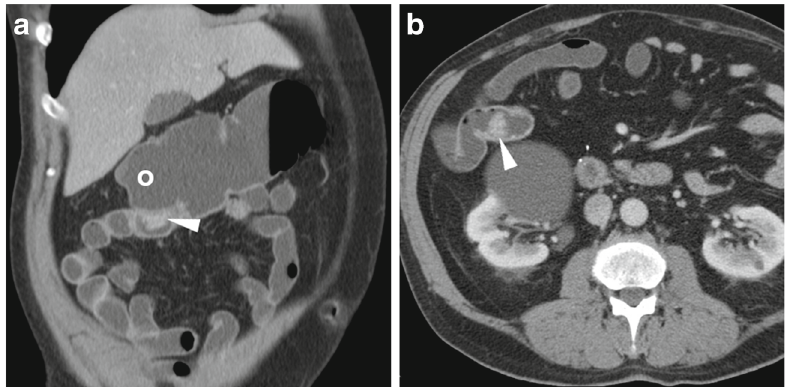
Fig. 10 Anastomotic ulcer in a 78-year-old male with history of extended right hemicolectomy for pT3N1 colon carcinoma. Previous endoscopy revealed irregularly hyperaemic side-to-side ileo-colic anastomosis with biopsy findings indicating severe acute and chronic inflammation. Performed without intravenous contrast because of impaired renal